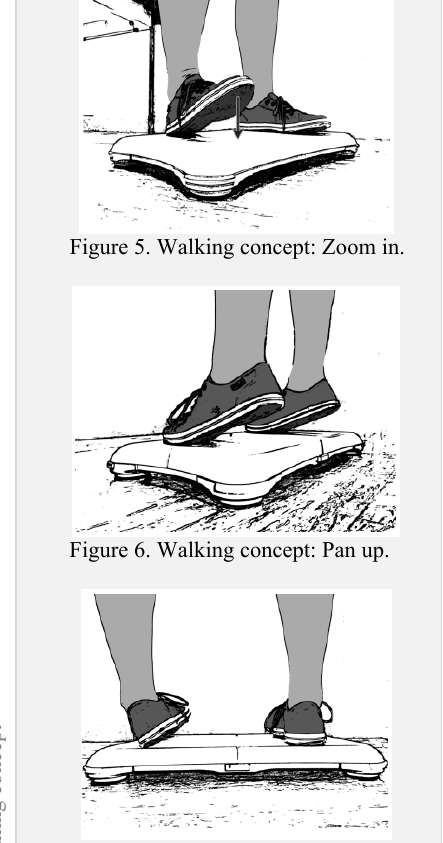
Figure 4. Surfing concept: Pan left.